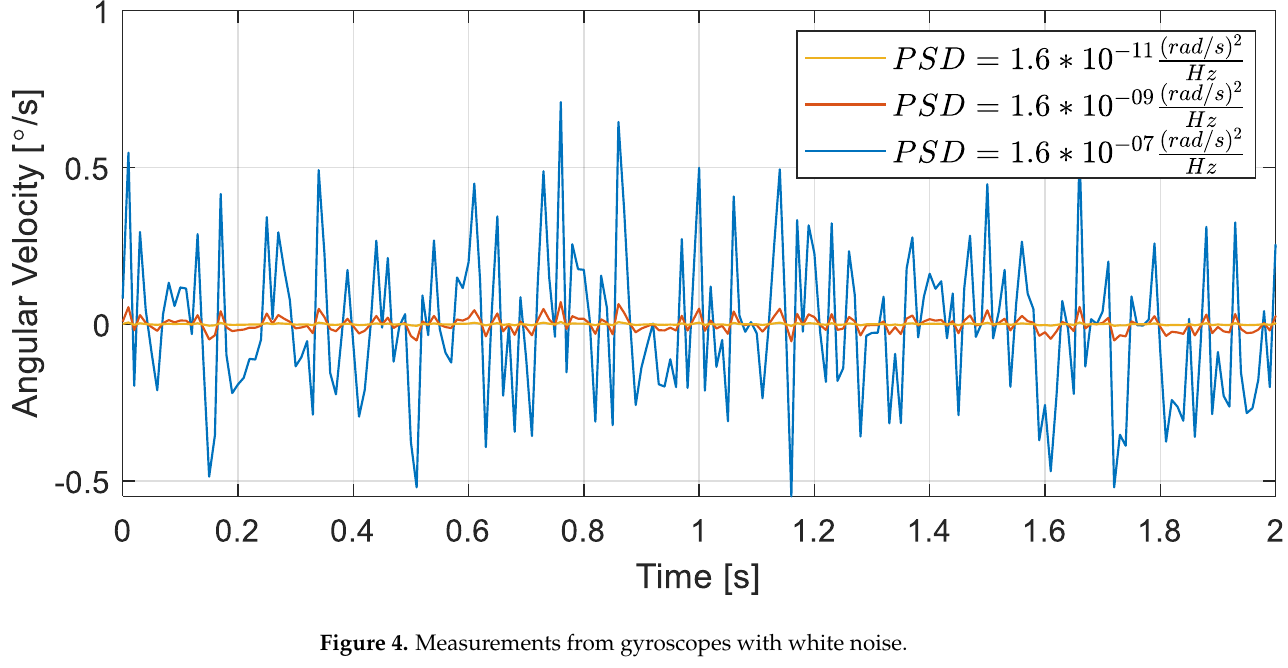
Aerospace 2022 , 9 , x FOR PEER REVIEW Figure 4. Measurements from gyroscopes with white noise.